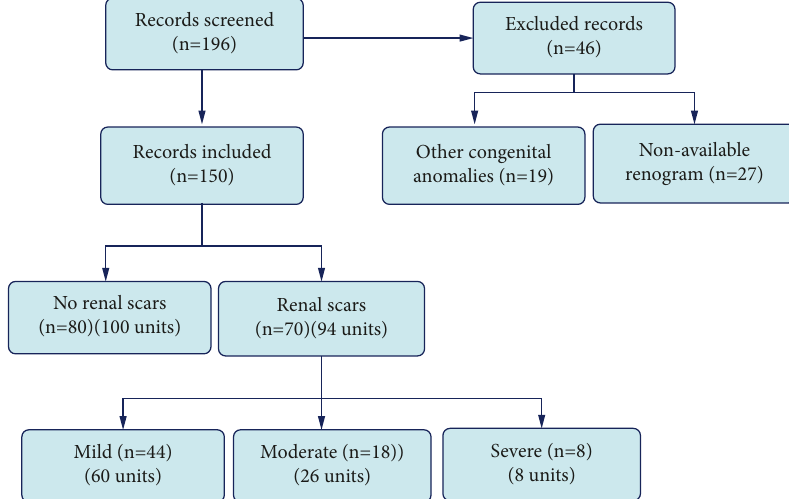
Figure 3: Flowchart of the